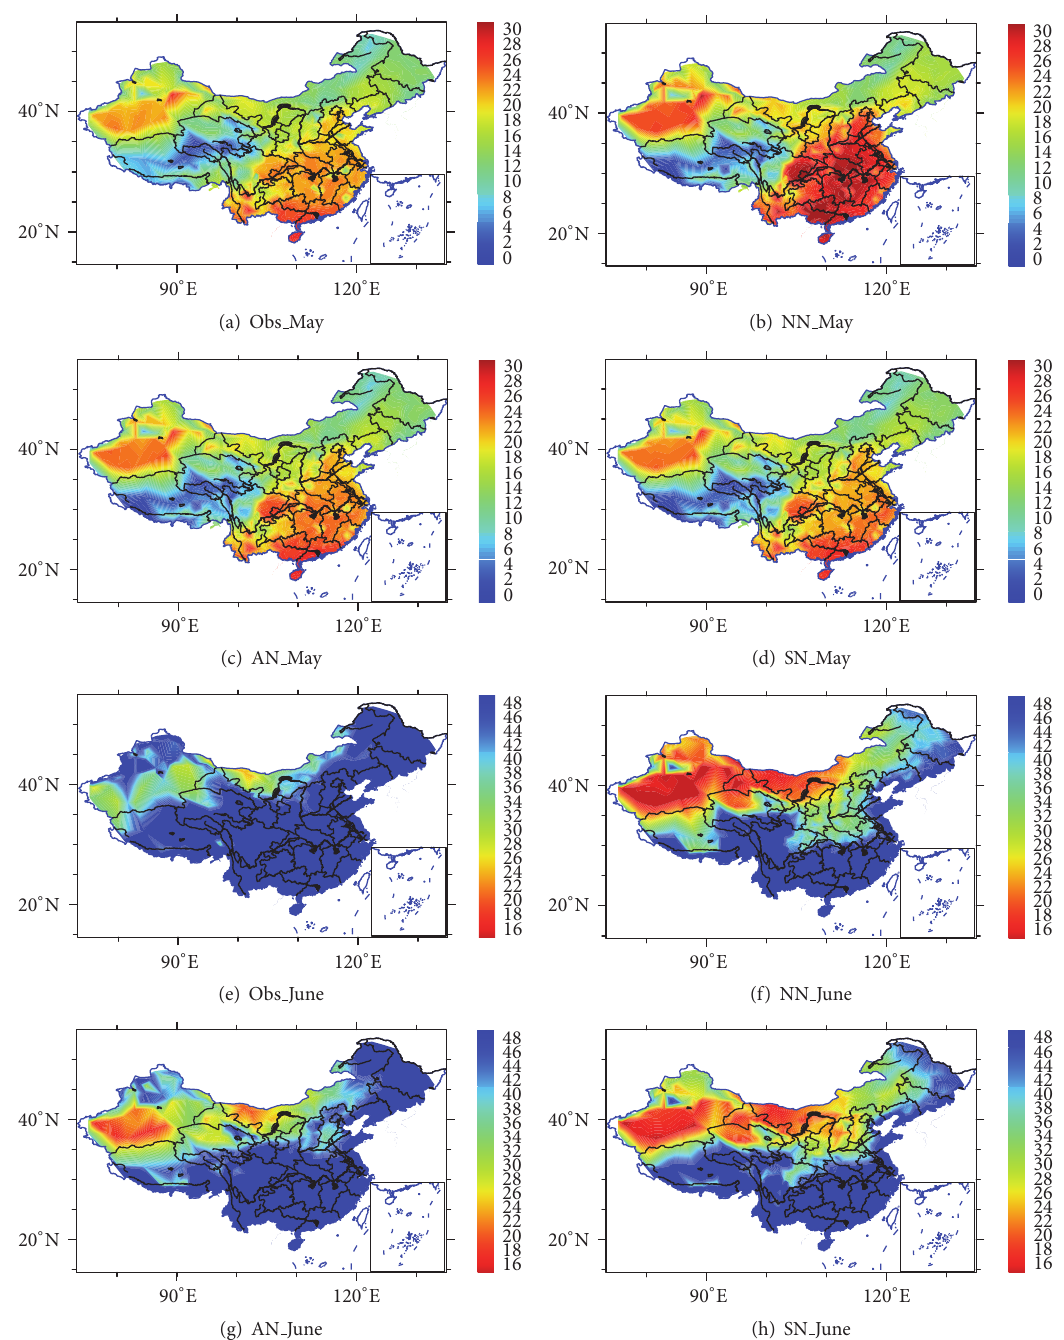
Figure 5: Comparison of 2 m temperature ( ∘ C) in May 2011 ((a)–(d)) and 2 m relative humidity (%) in June 2011 ((e)–(h)): (a), (e) the observed value, (b), (f) WRF simulated results with no nudging (NN), (c), (g) WRF simulated results with analysis nudging (AN), and (d), (h) WRF simulated results with spectral nudging